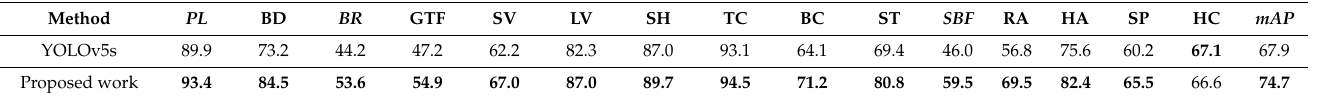
Table 1. Accuracy comparison between YOLOv5 and proposed